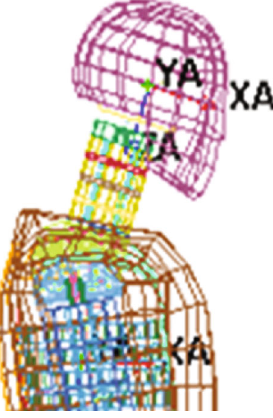
Figure 6: The head and thorax accelerometer location.